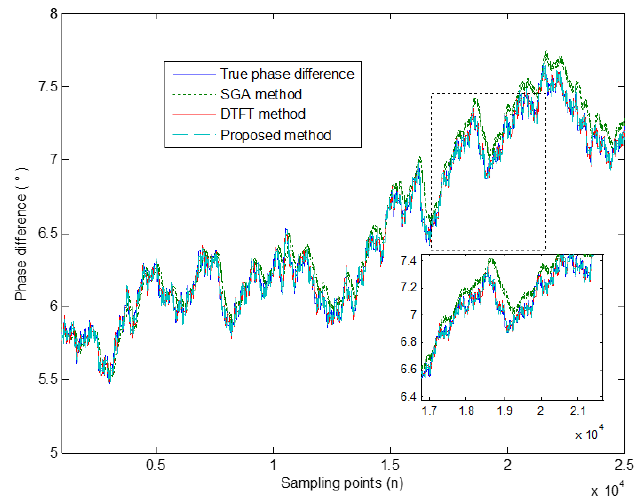
Figure 5. Varying phase differences estimated by three methods.